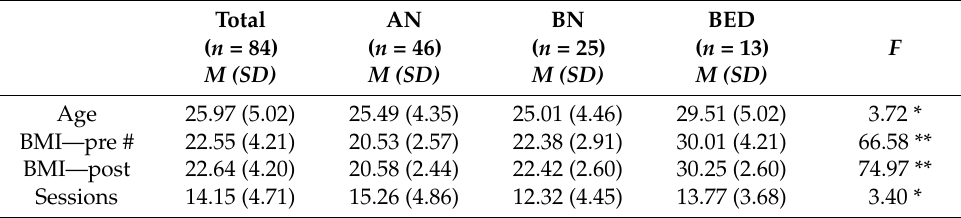
Table 1. Characteristics of the total sample and the three diagnostic